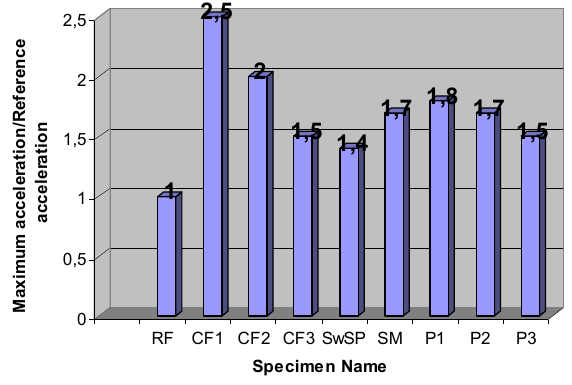
Figure 27 Comparison of test results Fig. 27. Comparison of test